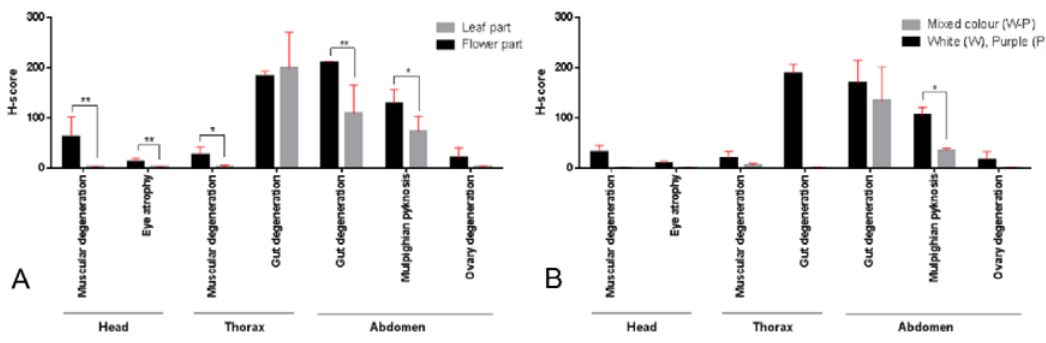
Figure 5. Comparison of histopathological scores as influenced by extracts based on either ( A ) part or ( B ) type of plants; bar graphs exhibit the H-score of any histopathological change between essential oils of leaf and flower parts in white and purple and white-purple or mixed colour of the plants. *: p < 0.05, **: p < 0.01.